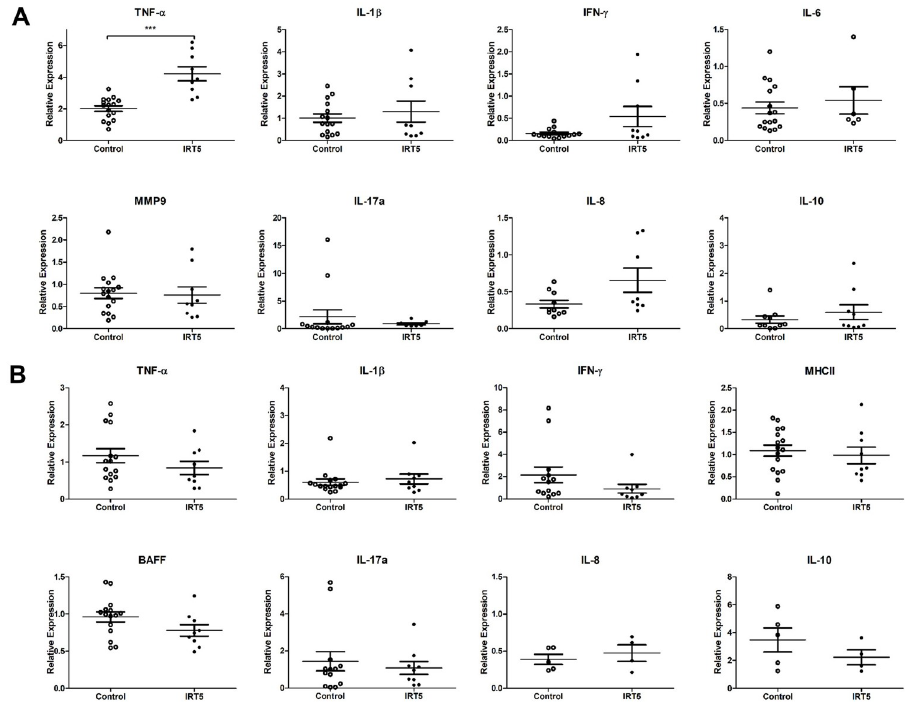
Fig 2. Quantative real-time PCR of cornea and conjunctiva, and extraorbital lacrimal gland. Quantative real-time PCR of inflammatory markers’ RNA transcripts was performed in cornea and conjunctiva (A), and extraorbital lacrimal gland (B). The results of quantative real-time PCR of cornea and conjunctiva are shown in A. It revealed increased TNF- α expression in IRT5 group (p < 0.001) whereas other markers did not significantly differ from control (A). The results of quantative real-time PCR of extraorbital lacrimal gland are shown in B. It did not show any significant differences in all inflammatory markers (p > 0.05) (B). Statistical analysis with error bars indicating mean and SEM of data points by Mann–Whitney U test: ��� p <